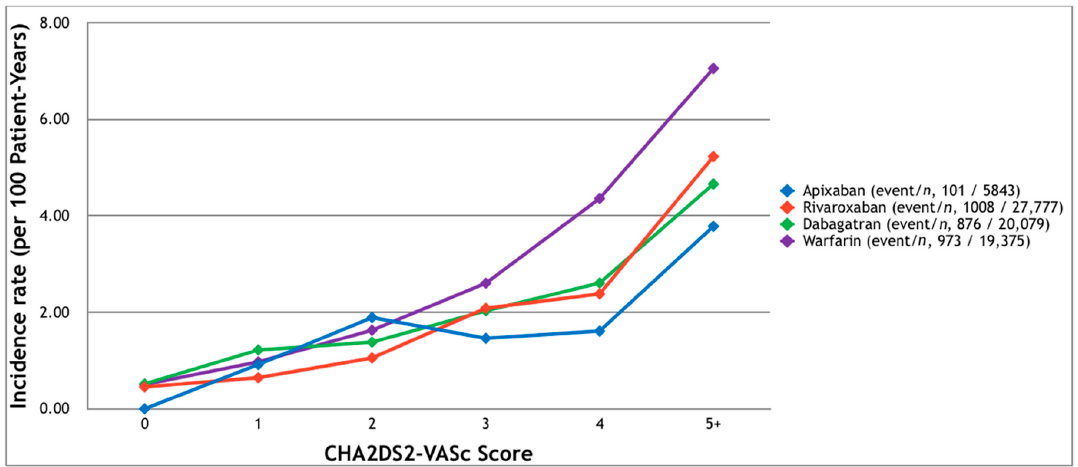
Figure 3. The incidence of ischemic stroke or systemic emboli requiring hospitalization among patients with non-valvular atrial fibrillation receiving oral anticoagulants. Ischemic stroke and systemic emboli occurred more frequently in the patients with higher CHA 2 DS 2 -VASc scores.